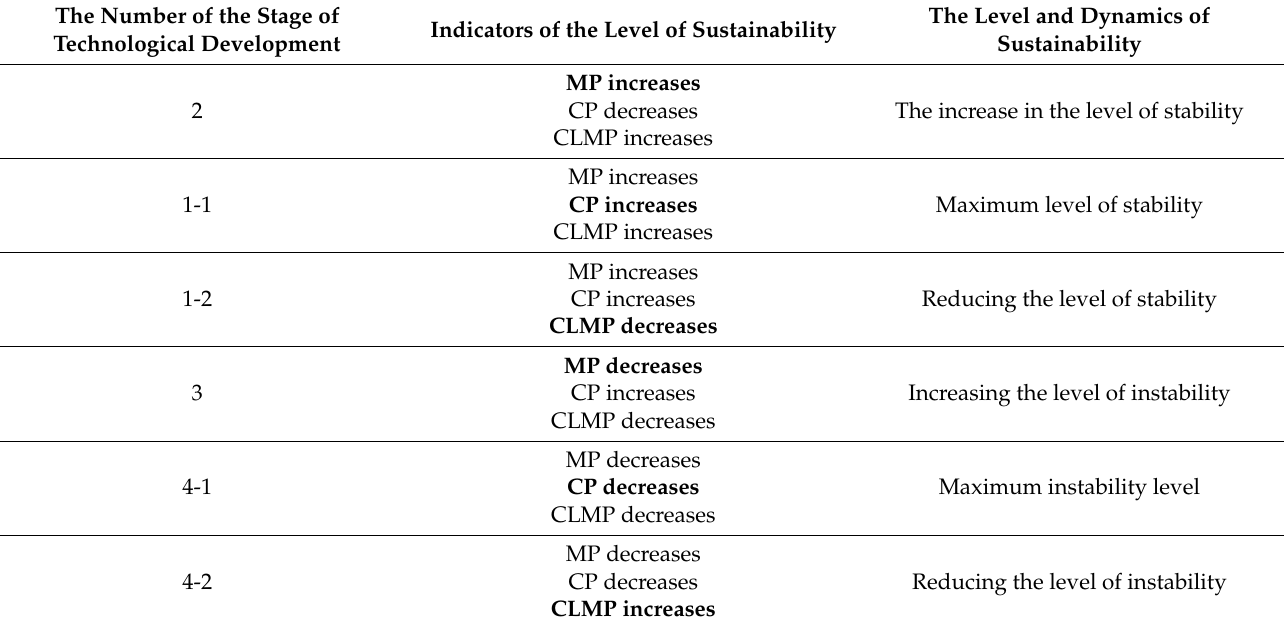
The Level and Dynamics